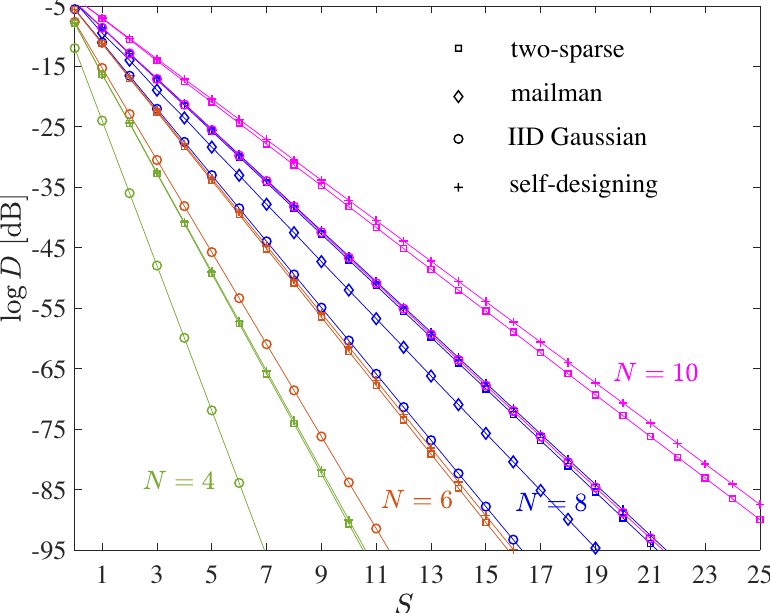
Figure 5. Median total squared error D for target matrix of unit Frobenius norm vs. the parameter S (approximately the total number of additions per column required for all wiring matrices). Gaussian IID target matrices of size N × 256. Results are averaged over 10 6 random matrix